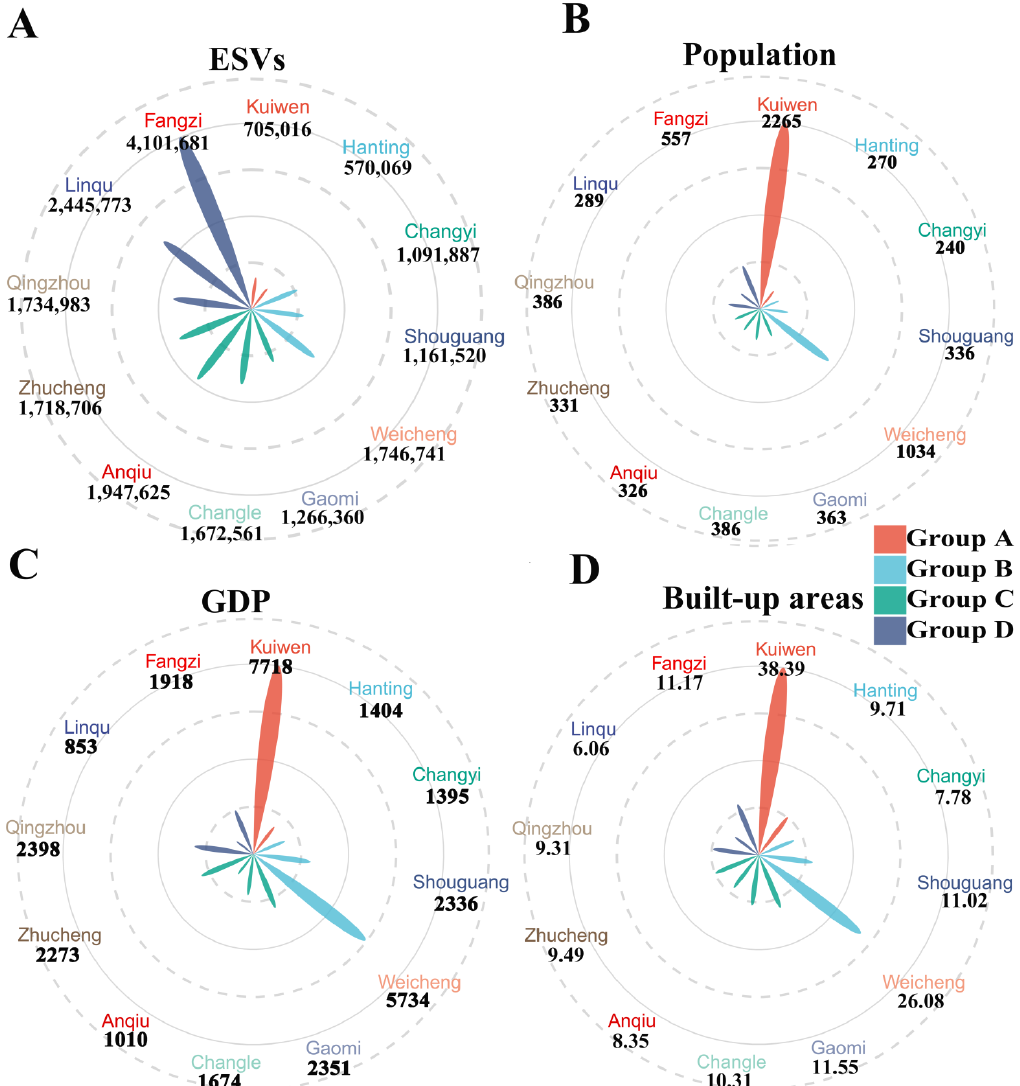
Figure 5. ESVs ( A , yuan/km 2 ), population density ( B , person/km 2 ), GDP density ( C , 10 4 yuan/km 2 ), and built-up areas ( D , %) in Weifang in 2015. Note: Group A includes Hanting and Kuiwen; Group B includes Changyi, Shouguang, and Weicheng; Group C includes Anqiu, Changle, Gaomi, and Zhucheng; and Group D includes Fangzi, Linqu, and Qingzhou. The same symbols are used